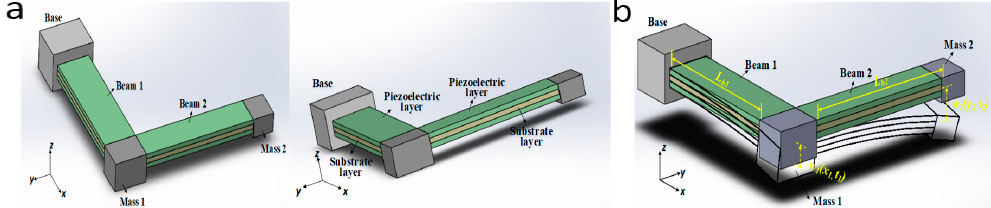
Figure 3. ( a ) The schematic of the wideband piezoelectric vibration energy harvester ( b ) The bending vibration mode of the wideband piezoelectric vibration energy harvester.